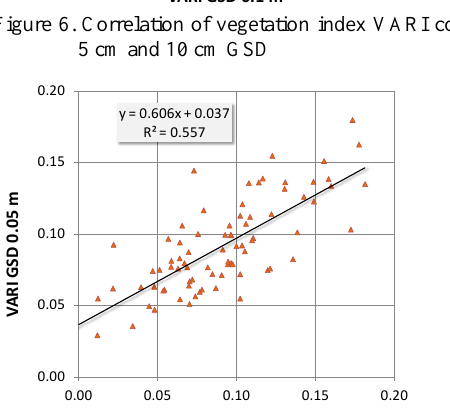
Figure 7. Correlation of vegetation index VARI computed from 5 cm and 50 cm GSD